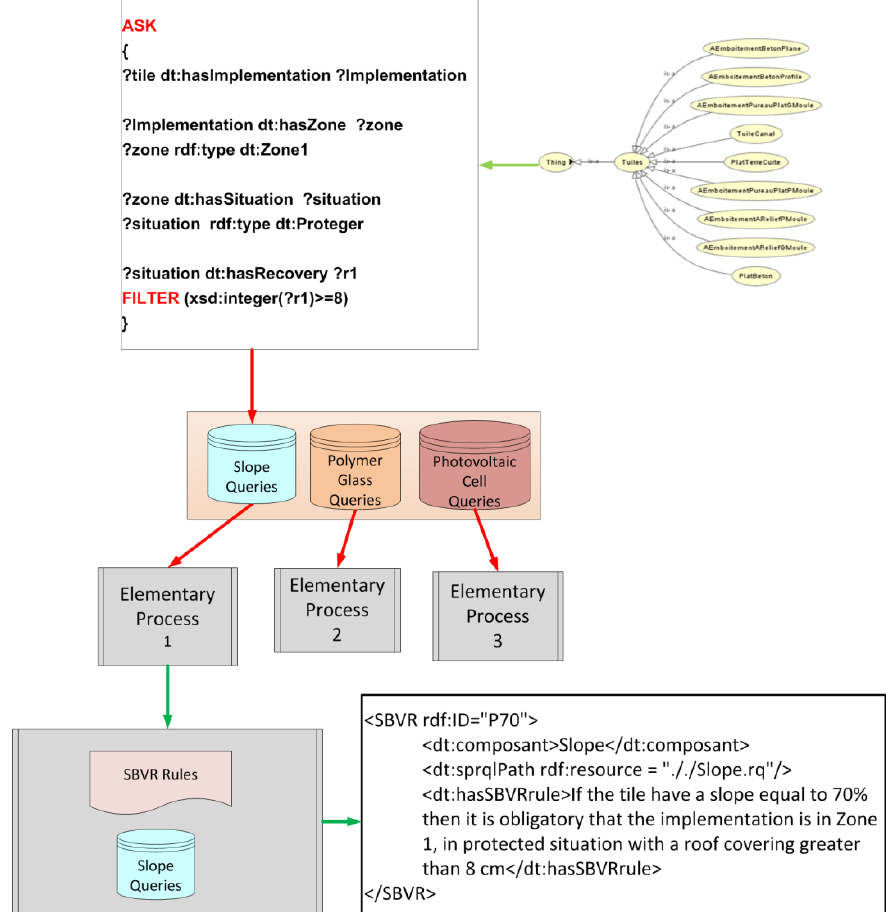
Figure 12. Elementary process of checking